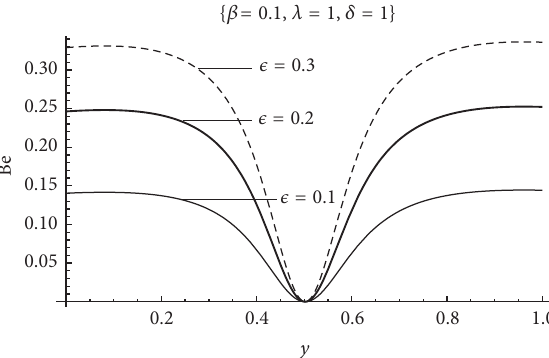
Figure 5: Bejan number at different activation energy parameter.